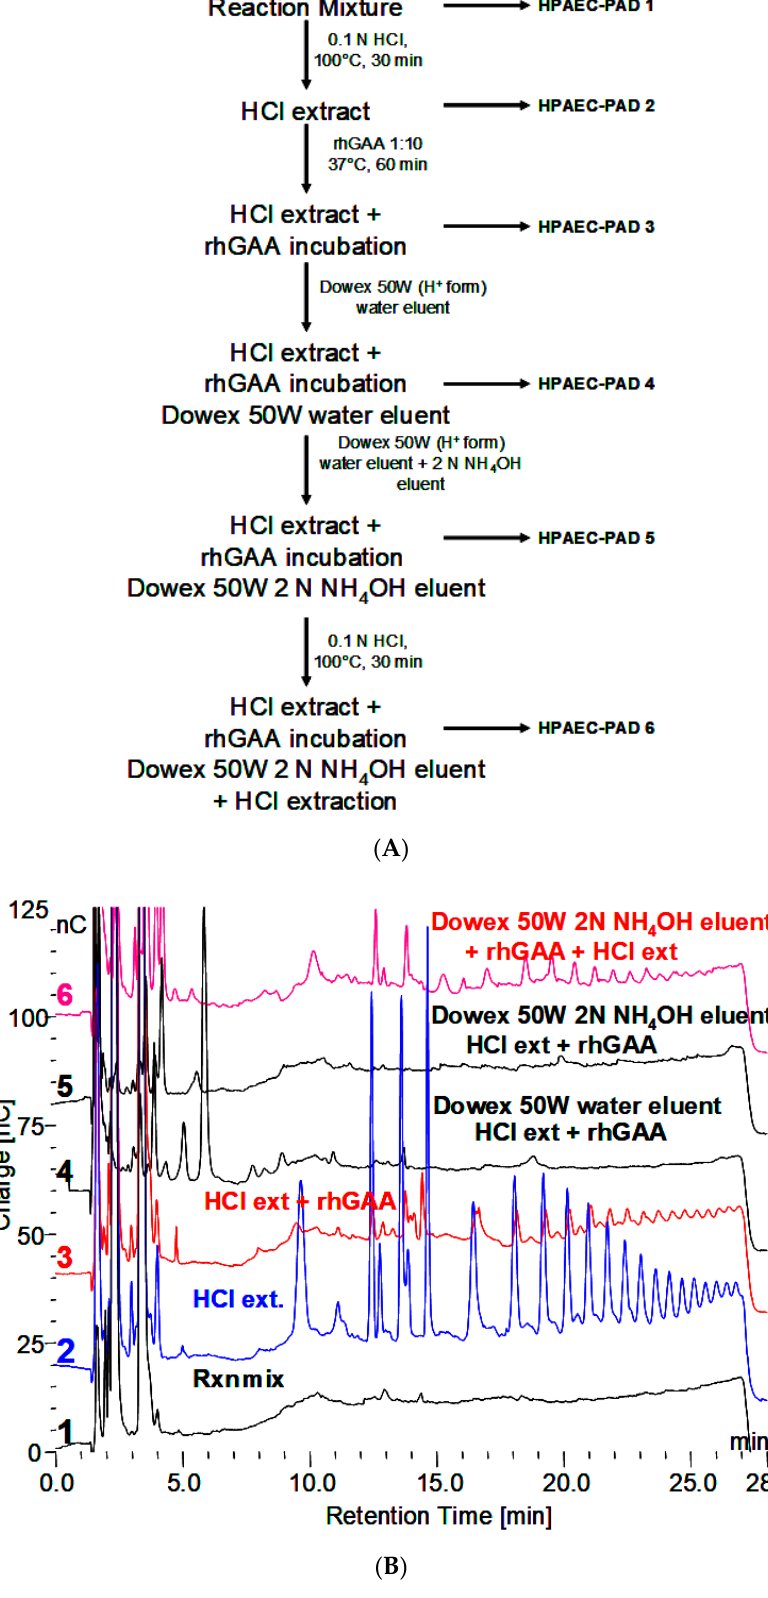
Figure 2. ( A ) Extraction procedures for incubation medium from rhGAA degradation of Control 2 glycogen after no more glucose is released. HPAEC-PAD numbers 1–6 refer to chromatograms 1–6 in 2B. ( B ) Results of samples analysis at each of sic steps in 2A.